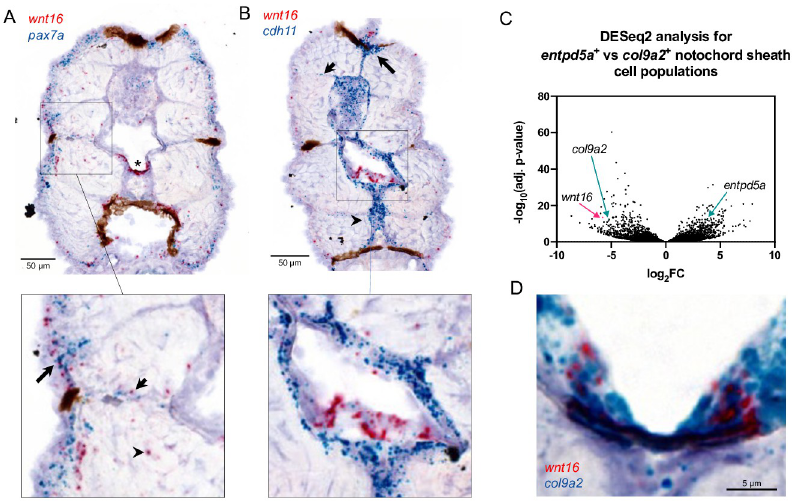
Fig 5. wnt16 is expressed in the ventral midline of the notochord sheath. (A, B) Chromogenic in situ hybridization was performed in transverse sections through the zebrafish trunk at 12 dpf. (A) Co-staining for wnt16 and pax7 . Staining for wnt16 was detected in notochord (star) and was mostly negative for pax7a . Staining for wnt16 was also detected in cells in the lateral portion of the myotome (inset, long arrow), within or adjacent to presumptive myosepta (inset, short arrow), and sporadically within the myotome (inset, arrowhead). (B) Co-staining for wnt16 and cdh11 . Staining for cdh11 was apparent in cells surrounding the notochord, the dorsal myotome (long arrow), presumptive myosepta (short arrow), and the medial portion of the ventral myotome (arrowhead). With regard to notochord, staining for wnt16 was localized within a single layer of cells surrounded by cells staining positively for cdh11 (inset). (C) Analysis of RNA-seq data from [18] shows that wnt16 is differentially expressed in col9a2 + relative to entpd5a + sheath cells. (D) Co-staining for wnt16 and col9a2 shows co-localization at the ventral midline of the notochord